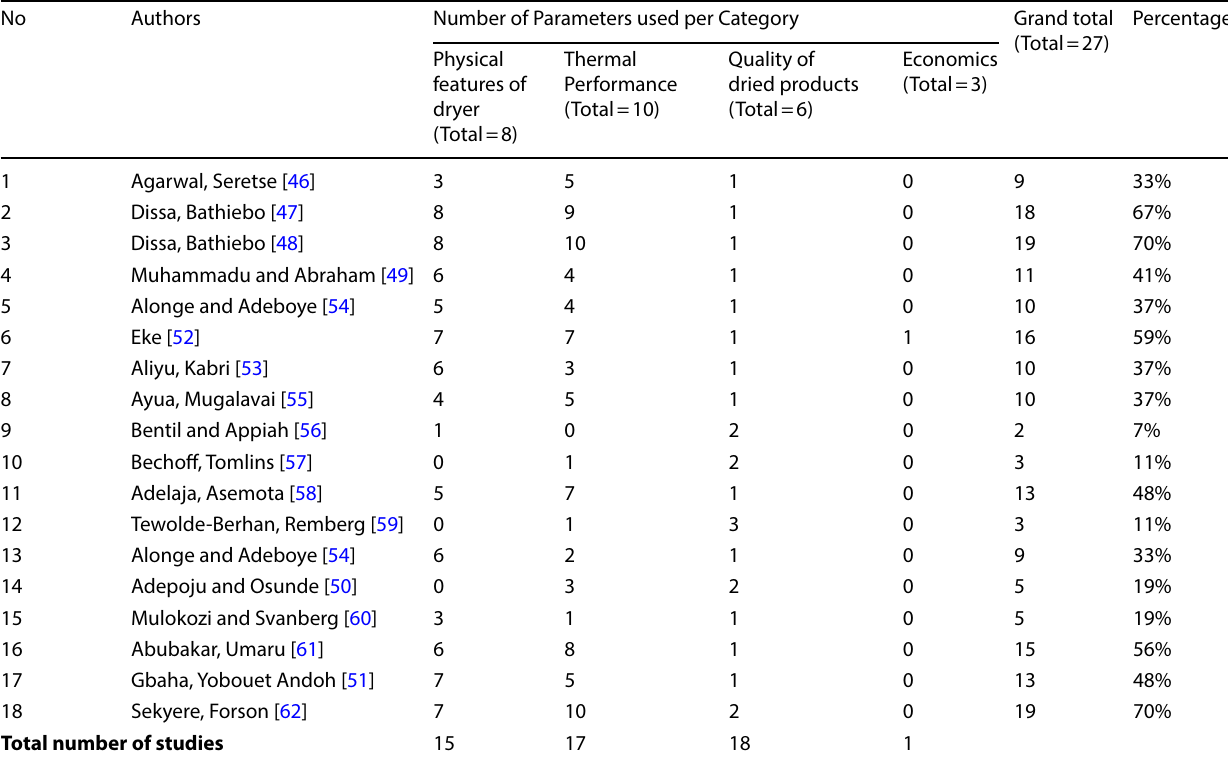
Table 3 Number of parameters used to assess solar dryer performance in each study